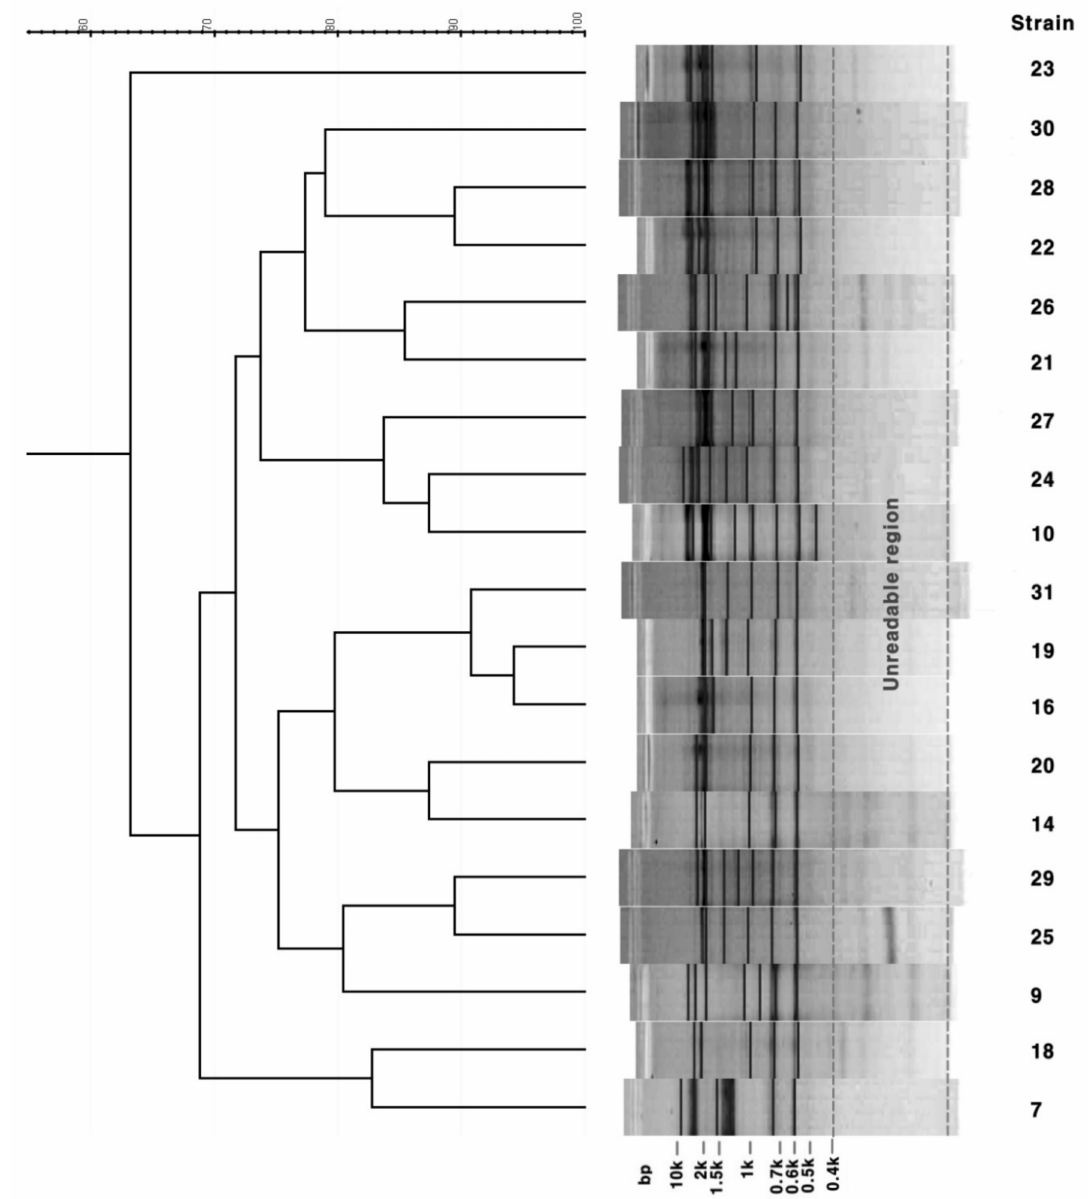
Figure 3. Cluster analysis of 19 M. intracellulare based on repetitive sequence based-PCR patterns.